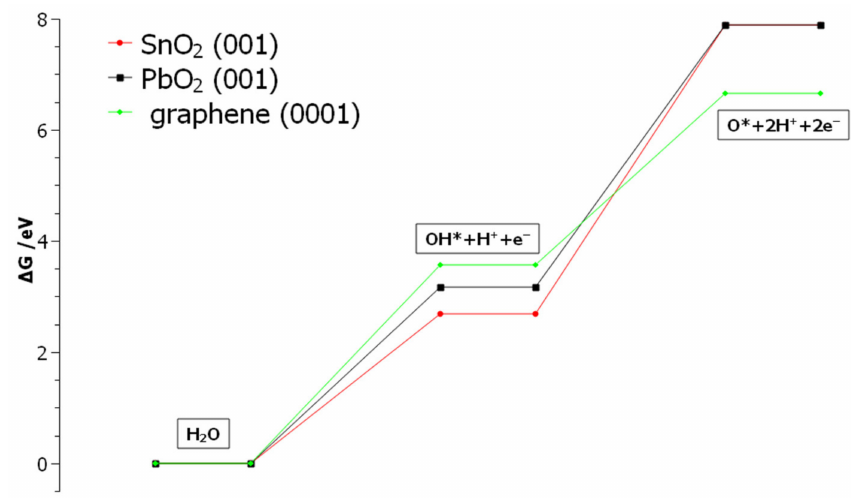
Figure 9. Calculated energetic profiles of OER step 1 (Equation (3)) and step 2 (Equation (4)) at the potential E = 0 V vs. RHE, on the investigated model surfaces graphene(0001), PbO 2 (001), and SnO 2 (001).”OH*” and “O*” denote adsorbed hydroxyl radical and adsorbed atomic oxygen,